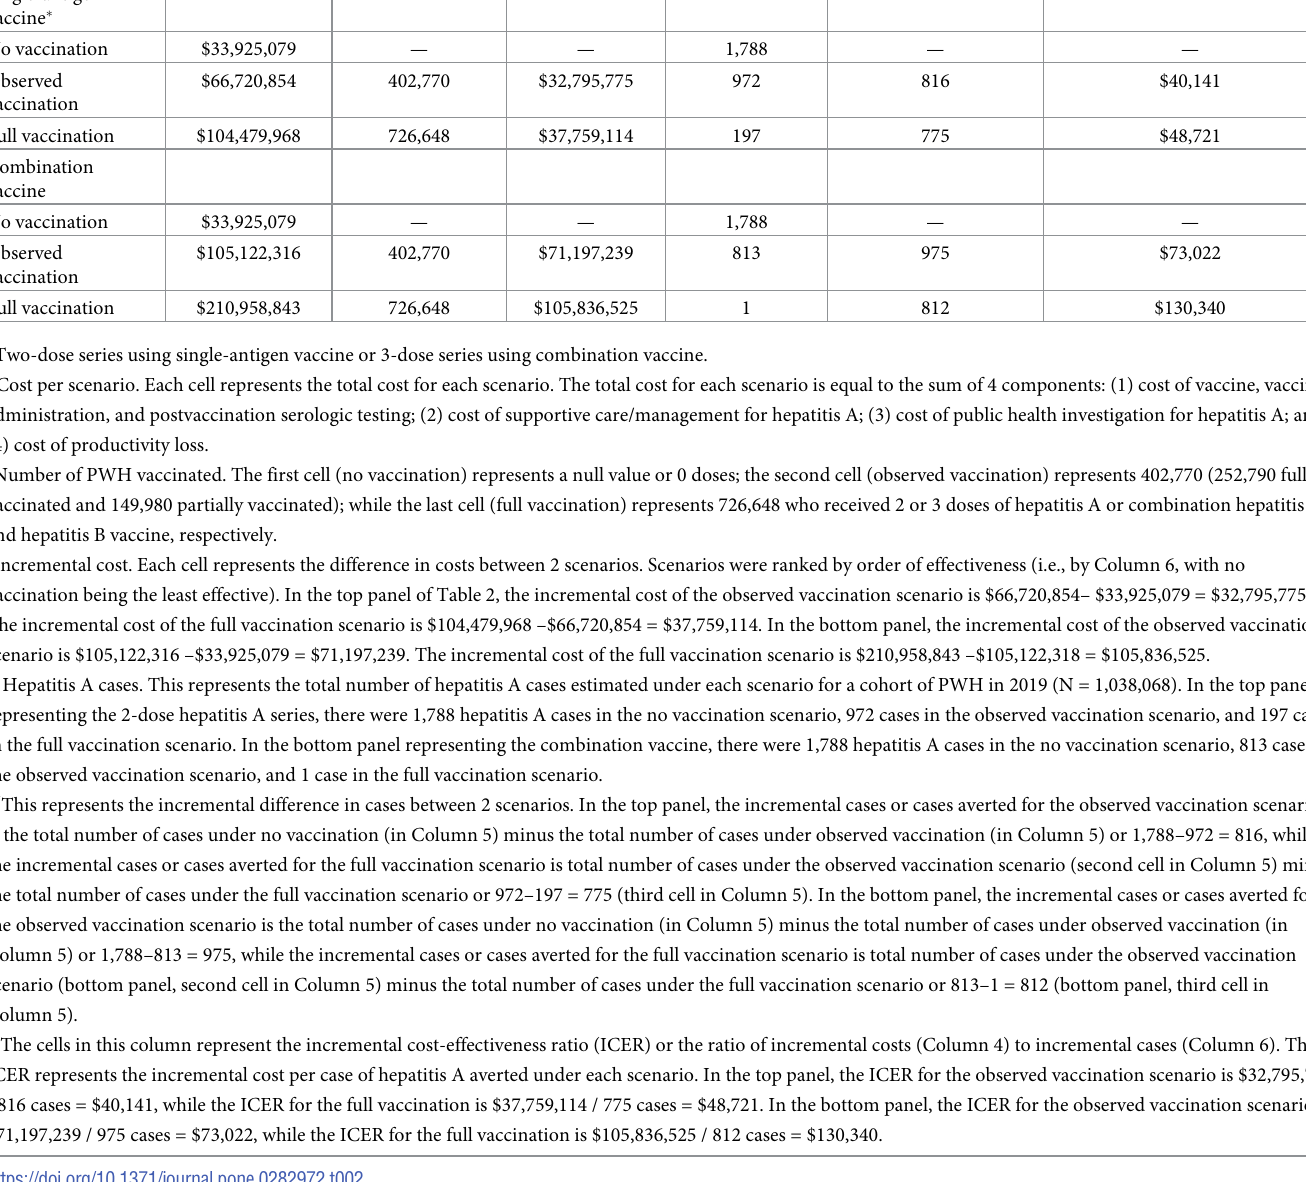
Table 2. Costs and effectiveness of hepatitis A vaccination among persons with HIV (PWH), United States, 2019, N = 1,038,068. Costs Per Scenario